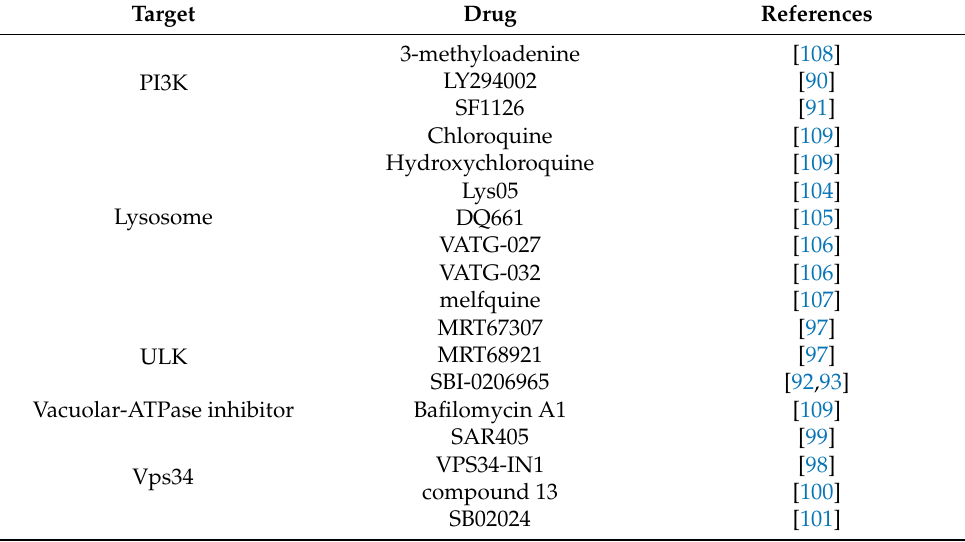
Table 1. Classification of autophagic inhibitors according to their location of